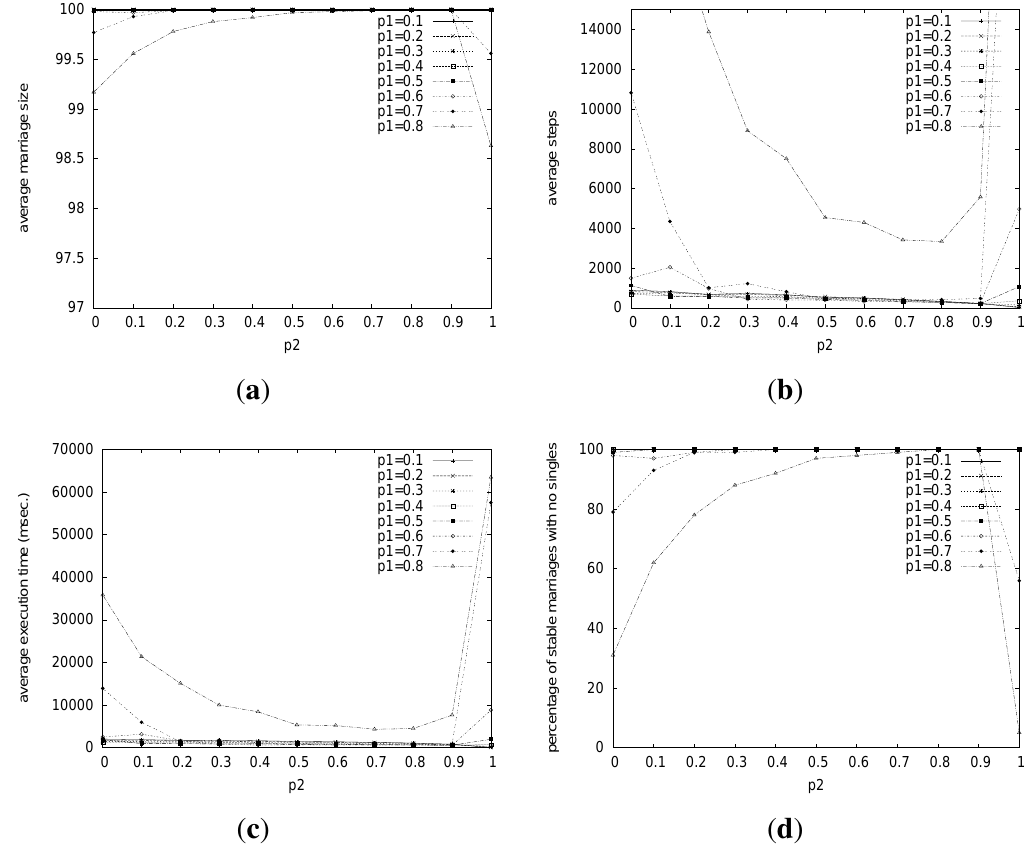
Figure 5. LTIU varying p for different values of p . ( a ) Average size of marriages; ( b ) 2 1 average number of steps; ( c ) average execution time; ( d ) percentage of perfect